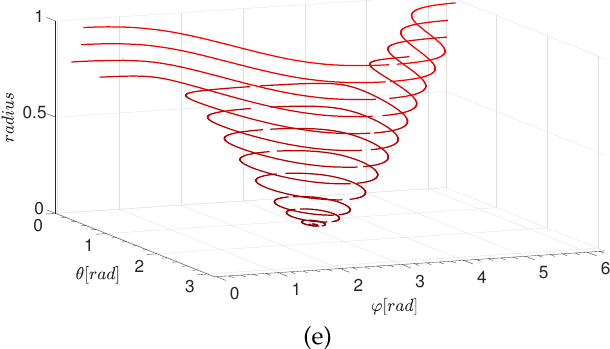
Figure 5. The locus of { θ , ϕ } pairs for selected values of θ i , ϕ i , and d . ( a , b ) The case of d = 0. ( a ): for two primary points with θ i = 70 ◦ ; blue: ϕ i = 120 ◦ , red: ϕ i = 0 ◦ . ( b ): for three primary points with ϕ i = 45 ◦ ; blue: θ i = 60 ◦ , red: θ i = 30 ◦ , green: θ i = 150 ◦ . ( c , d ) Same as ( a , b ) but for d = 0.5. ( e ) Illustrating the dependence on r = r ( d ) . Here the primary point is ϕ i = 180 ◦ , θ i = 70 ◦ .